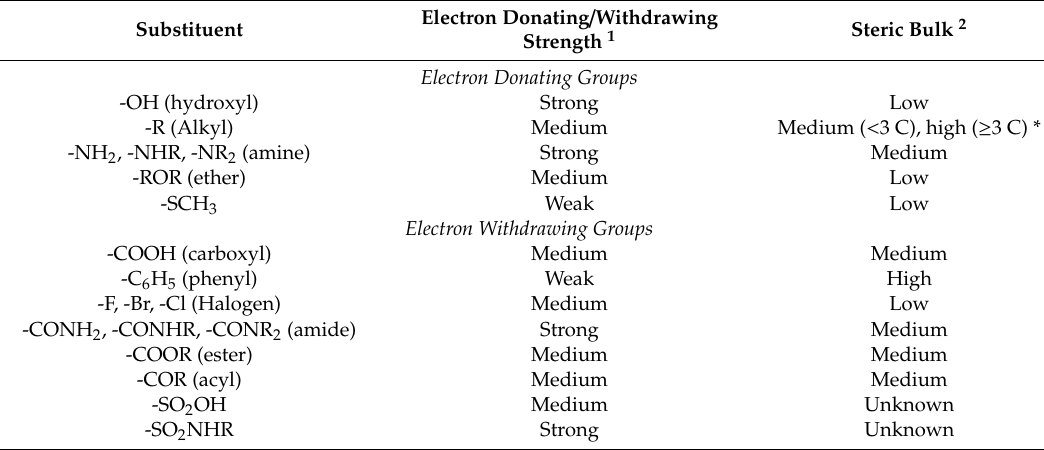
Table 2. Electron donating / withdrawing strength and steric bulk of shortlisted organic contaminant (OC)